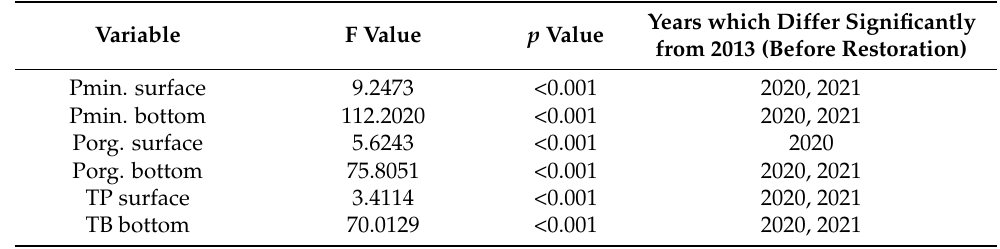
Years which Differ Significantly from 2013 (Before Restoration)